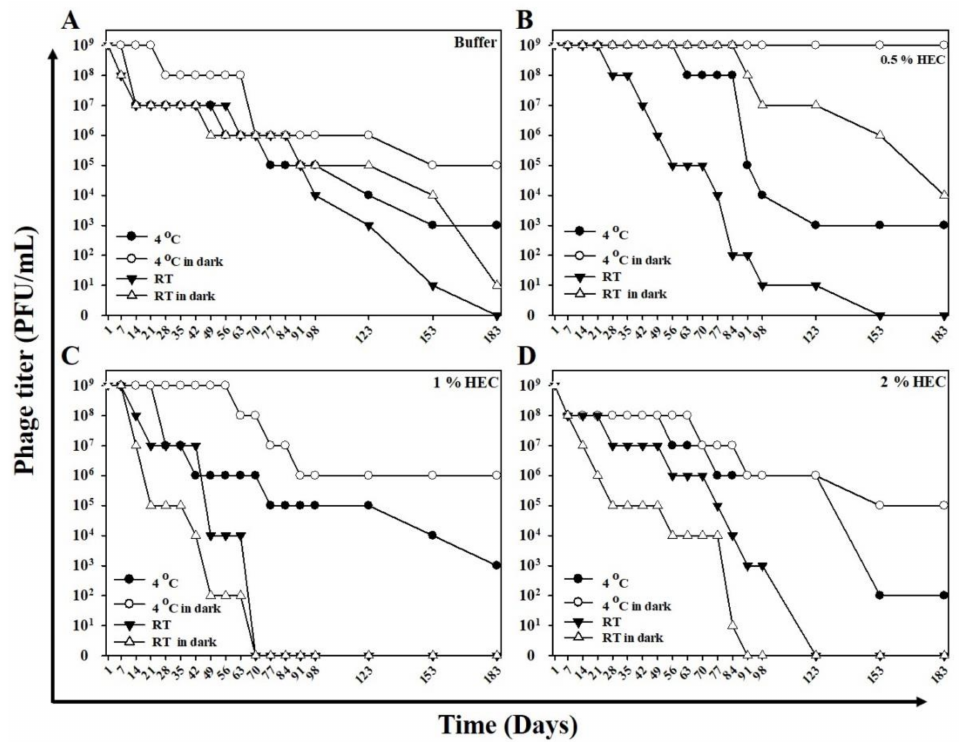
Figure 5. Lytic capacity and stability following storage of the phage HEC creams at different light exposures and temperatures. ( A ) TCUCAP1 in phage buffer as a control group. ( B ) TCUCAP1 per gram of 0.5% cream. ( C ) TCUCAP1 per gram of 1% cream. ( D ) TCUCAP1 per gram of 2% cream. All the cream formulations contained a concentration of 1 × 10 9 PFU/mL TCUCAP1 phage. • represents storage at 4 ◦ C in a transparent bottle. represents storage at 4 ◦ C in a light-protected (cid:35) bottle. (cid:72) represents storage at 22–25 ◦ C in a transparent bottle. ∆ represents storage at 22–25 ◦ C in a light-protected